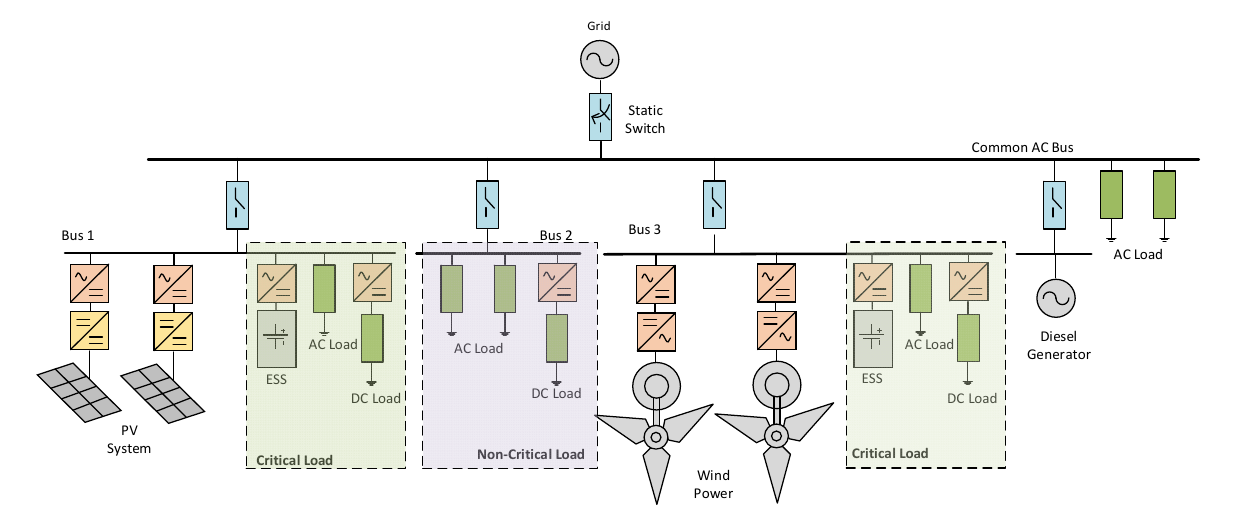
Figure 1. AC microgrid architecture.